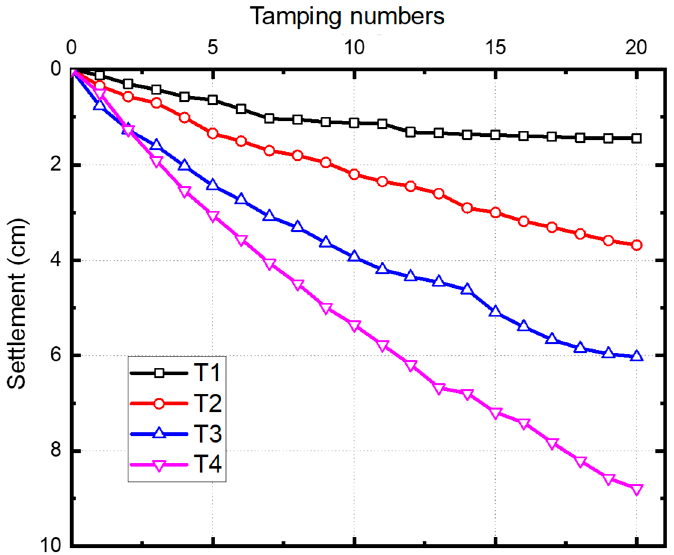
Figure 3. Relationship curves between the tamping settlement and the number of tamping blows for different tamping energy levels.